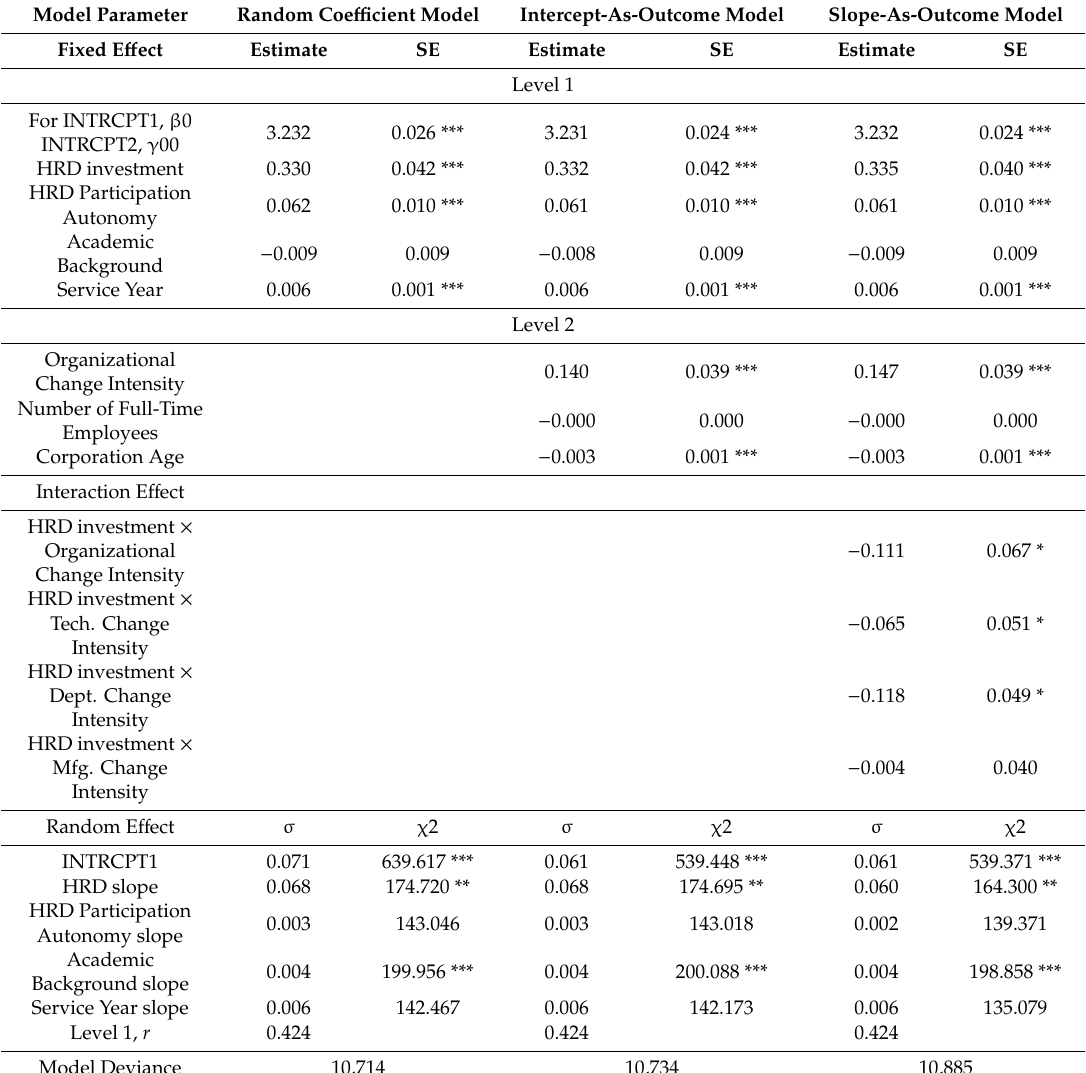
Table 3. Multilevel Regression Estimates and Model Comparisons across Three Models of Perception of Organizational